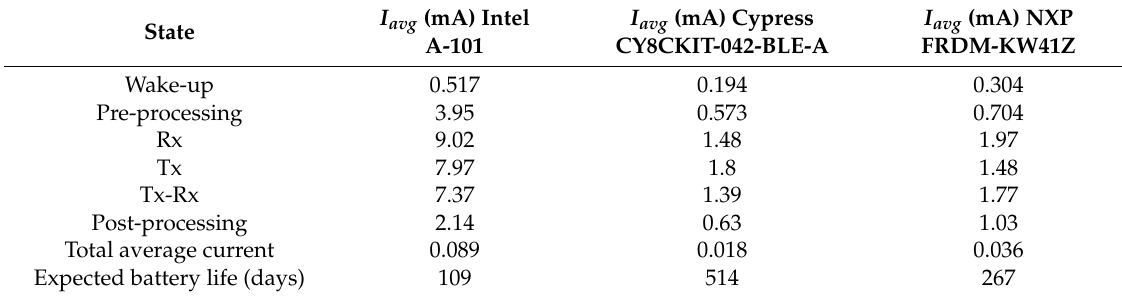
Table 3. Current consumption comparison between the platforms configured as a CD using a connection interval of 100 ms.